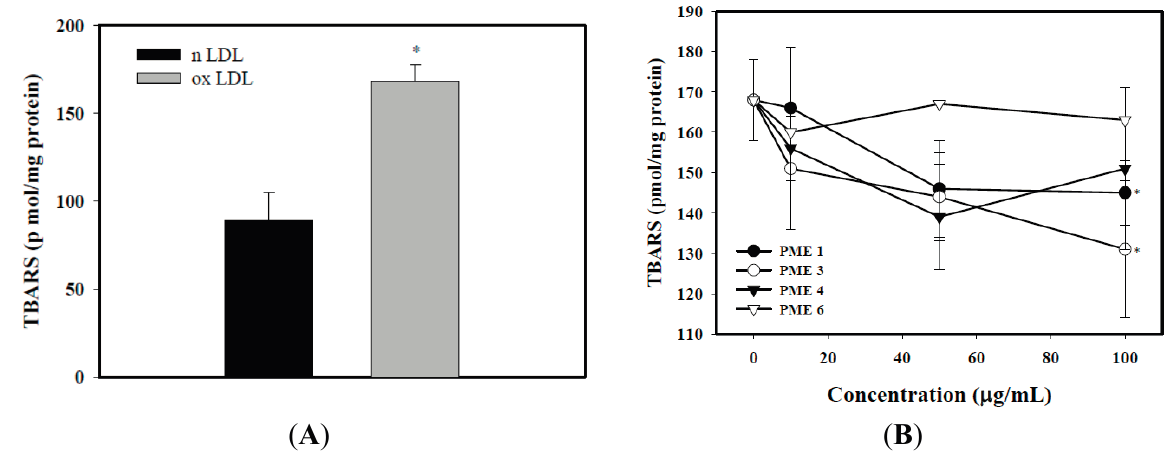
Figure 2. Thiobarbituric acid-reactive substances (TBARS) in RAW 264.7 macrophages incubated with n-LDL or ox-LDL (100 μ g/mL). ( A ) * indicate significantly different by comparison with n-LDL ( p < 0.05); ( B ) The inhibitory effects of Pinus morrisonicola extracts (PME) fractions 1, 3, 4, and 6. Asterisks are significantly different ( p < 0.05) as compared to zero concentration of PME. Data are expressed as means ± SD of three separate